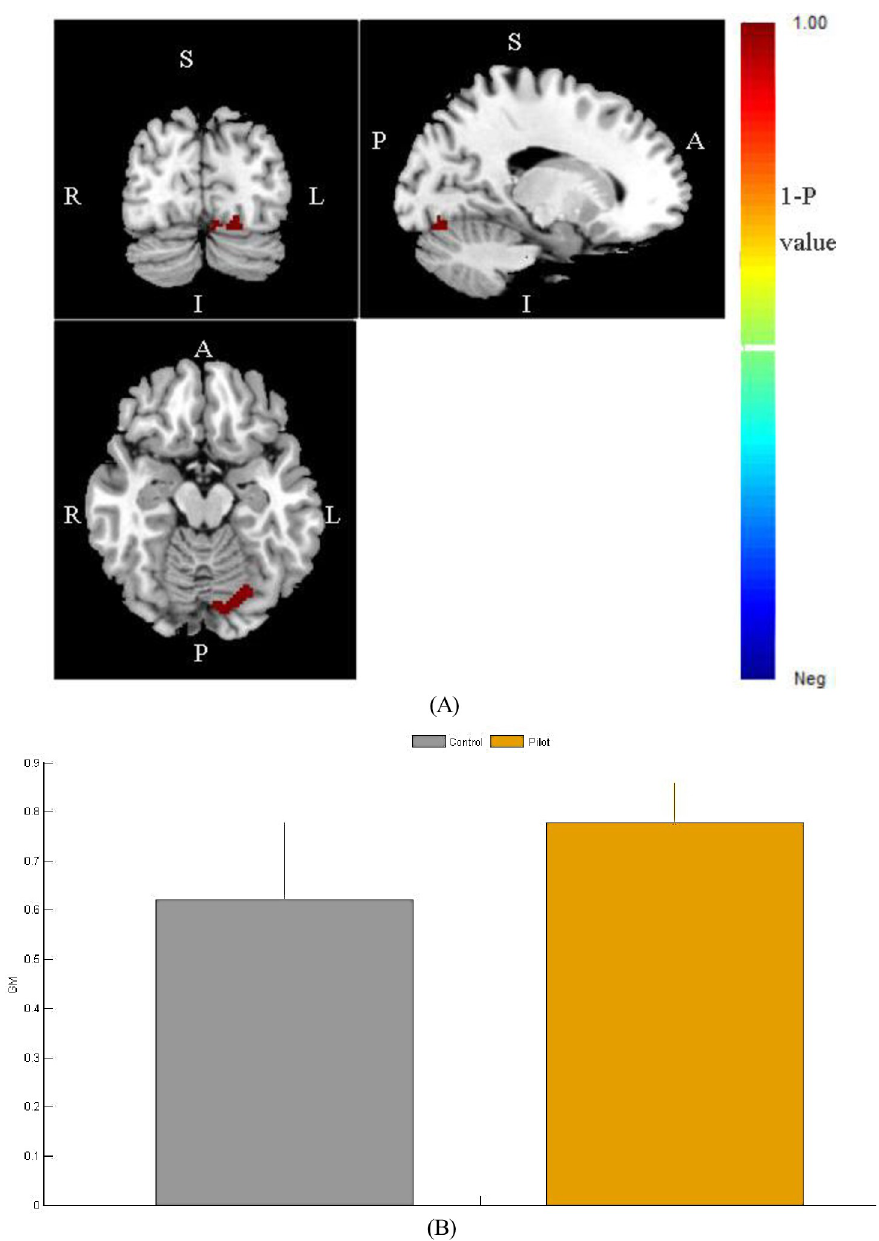
Fig 3. Brain regions with differences and comparison of gray matter volume between the two groups.